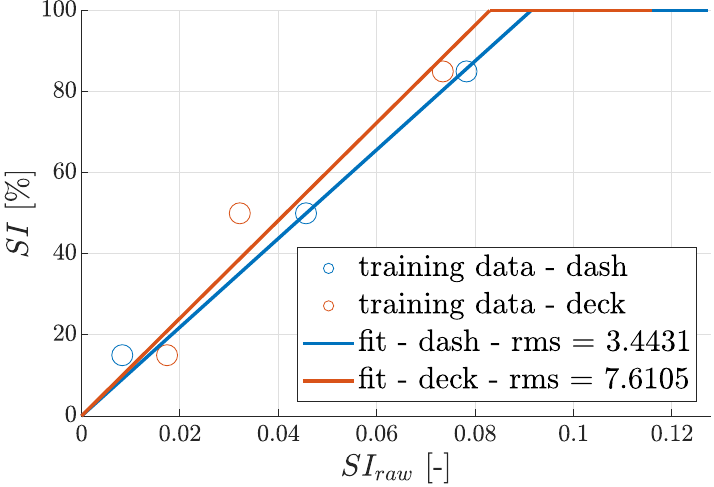
Figure 14. Safety Index calibration